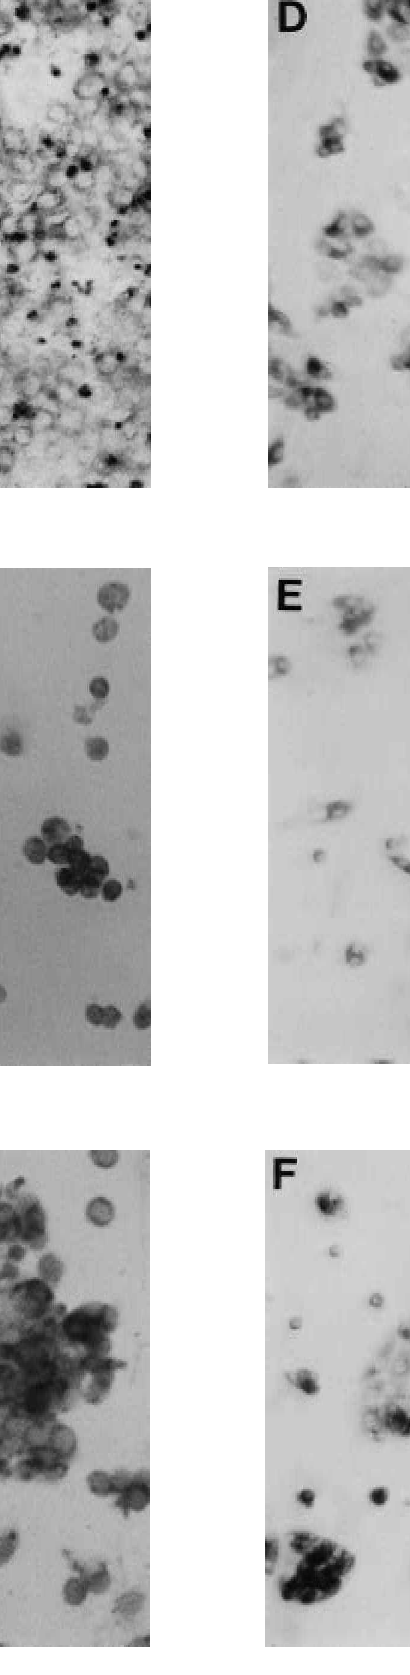
FIG. 1. Adherent alveolar type II cells (A ± C) and NCBSC (D ± F). Before treatment (A, D); after treatment with 24 pmol NE (B, E); after concurrent treatment with 24 pmol NE and 20 pmol PI (C,